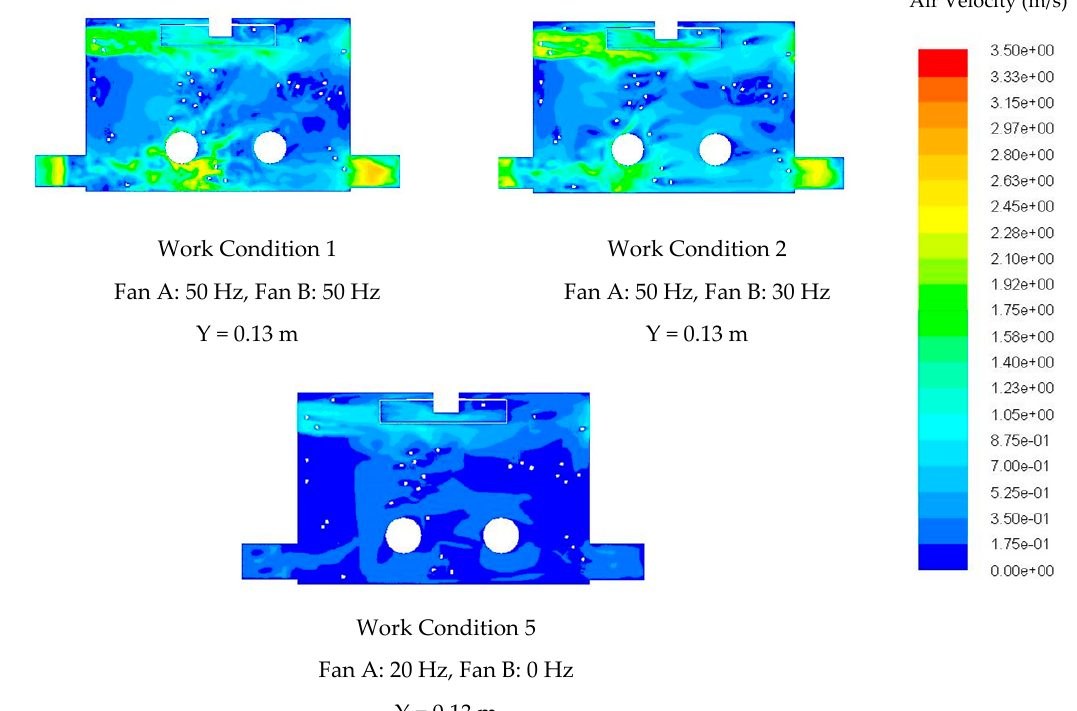
Figure 12. Simulated velocity contours of the broiler chamber with broilers.